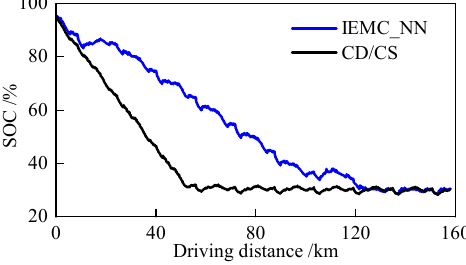
Figure 13. Battery SOC comparison for the condition of driving distance information unknown (LA92 cycle). CD/CS, charging deplete/charging sustain.